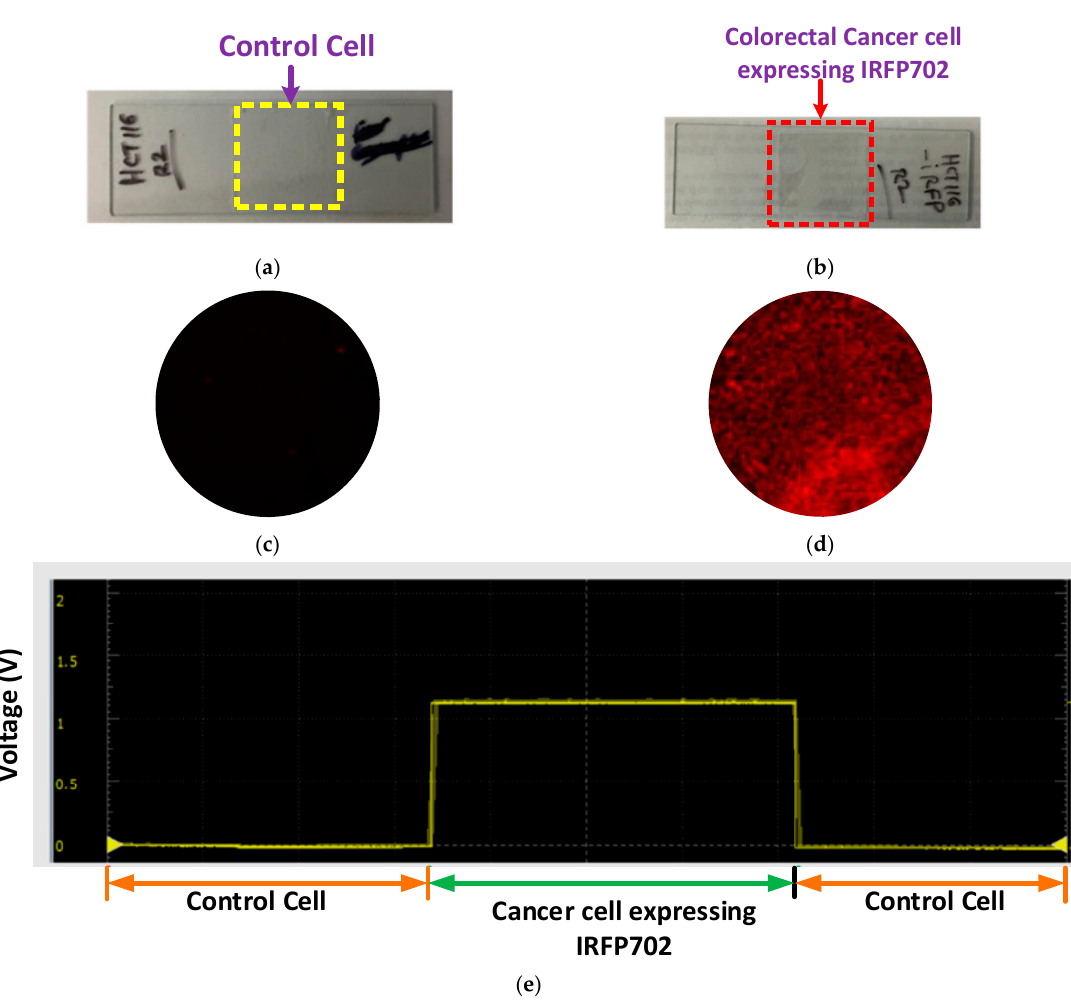
Figure 7. Results: ( a ) control colorectal cancer cell, ( b ) colorectal cancer cell expressing IRFP702 fluorophore, ( c ) control cell visualized with commercial system, ( d ) colorectal cancer cell expressing IRFP702 visualized with commercial system, and ( e ) reading on a waveform oscilloscope.